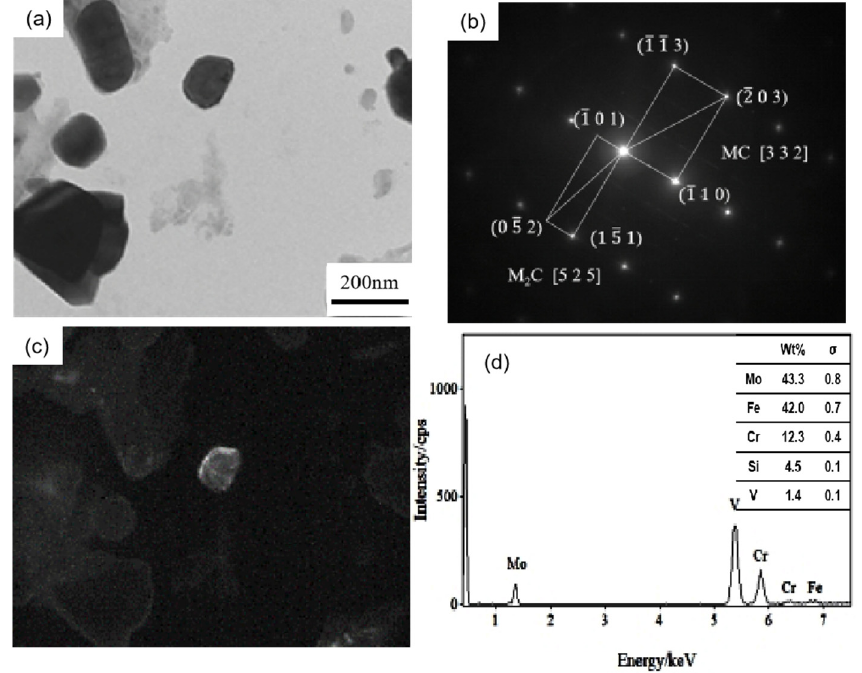
Figure 6. TEM of MC/M2C carbide in 0.3 Si steel after tempering for 64 h at 650 °C: ( a ) bright field image of carbide; ( b ) SAED pattern; ( c ) corresponding dark field image; ( d ) EDS analysis. Additionally, there are long rod-shaped carbides in the 0.3 Si steel sample (arrow